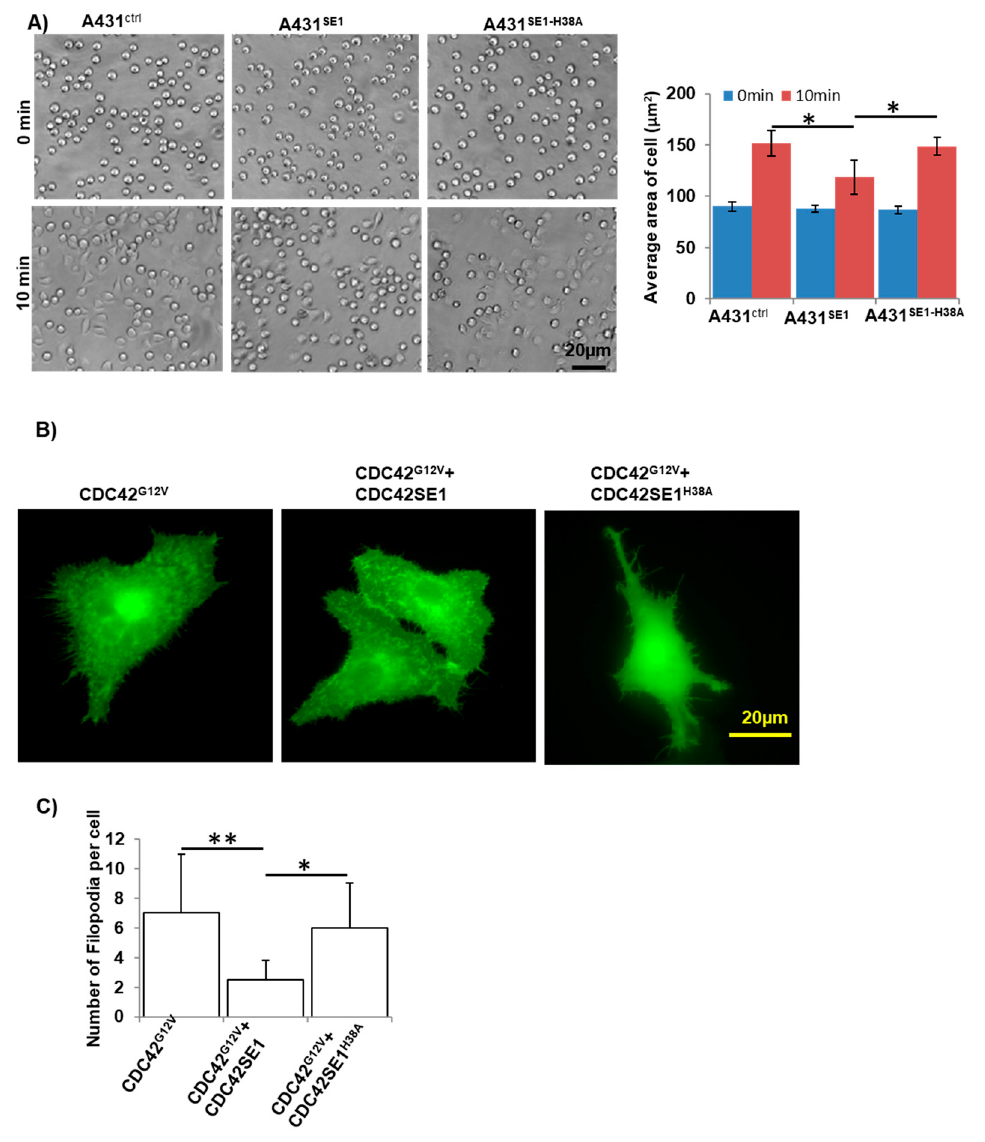
Figure 6. CDC42SE1 inhibits A431 cell spreading and CDC42 induced filopodia formation in A549 cells. ( A ) A431 Ctrl , A431 SE1 , and A431 SE1-H38A cells were seeded on fibronectin coated 96 well